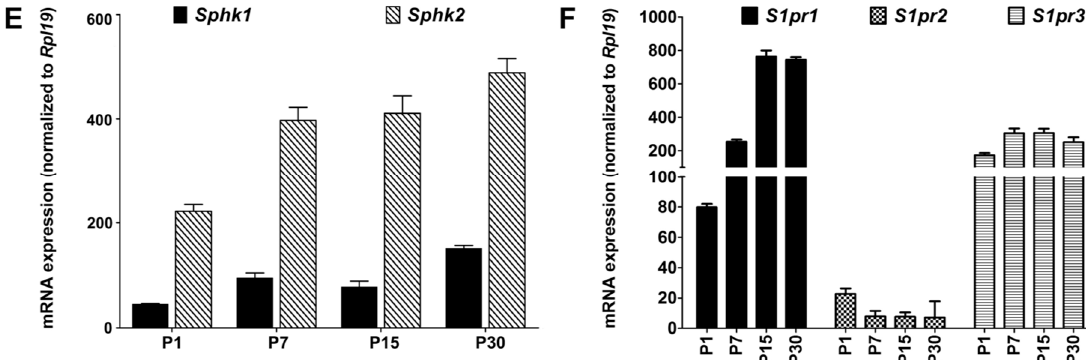
Figure 2. The expression and distribution of sphingosine kinase ( Sphk ) 1 and 2 and sphingosine 1-phosphate receptor ( S1pr ) 1, 2 and 3 mRNA in mouse eye tissues. Each bar shows the mean of three independent qRT-PCR experiments (±SE) normalized with the expression of the ribosomal protein Rpl19. ( A ) Sphk1 and Sphk2 expression profile in mouse eye tissues. ( B ) S1pr1-3 expression profile in mouse eye tissues. ( C ) Sphk1-2 expression profile in embryonic and adult whole mouse eyes. ( D ) S1pr1-3 expression profile in embryonic and adult whole mouse eyes. ( E ) Sphk1-2 expression profile in developing mouse retinas from postnatal day 1 (P1) to P30. ( F ) S1pr1-3 expression profile in developing mouse retinas from P1 to P30. Cor, cornea. I-CB, iris/ciliary body. ON, optic nerve. EC, eye cup. Ret, retina. E15, 15 day embryo. E18, 18 day embryo. 2M, 2 months aged. 7M, 7 months aged. P1, P7, P15 and P30 are postnatal day 1, 7, 15 and 30, respectively.